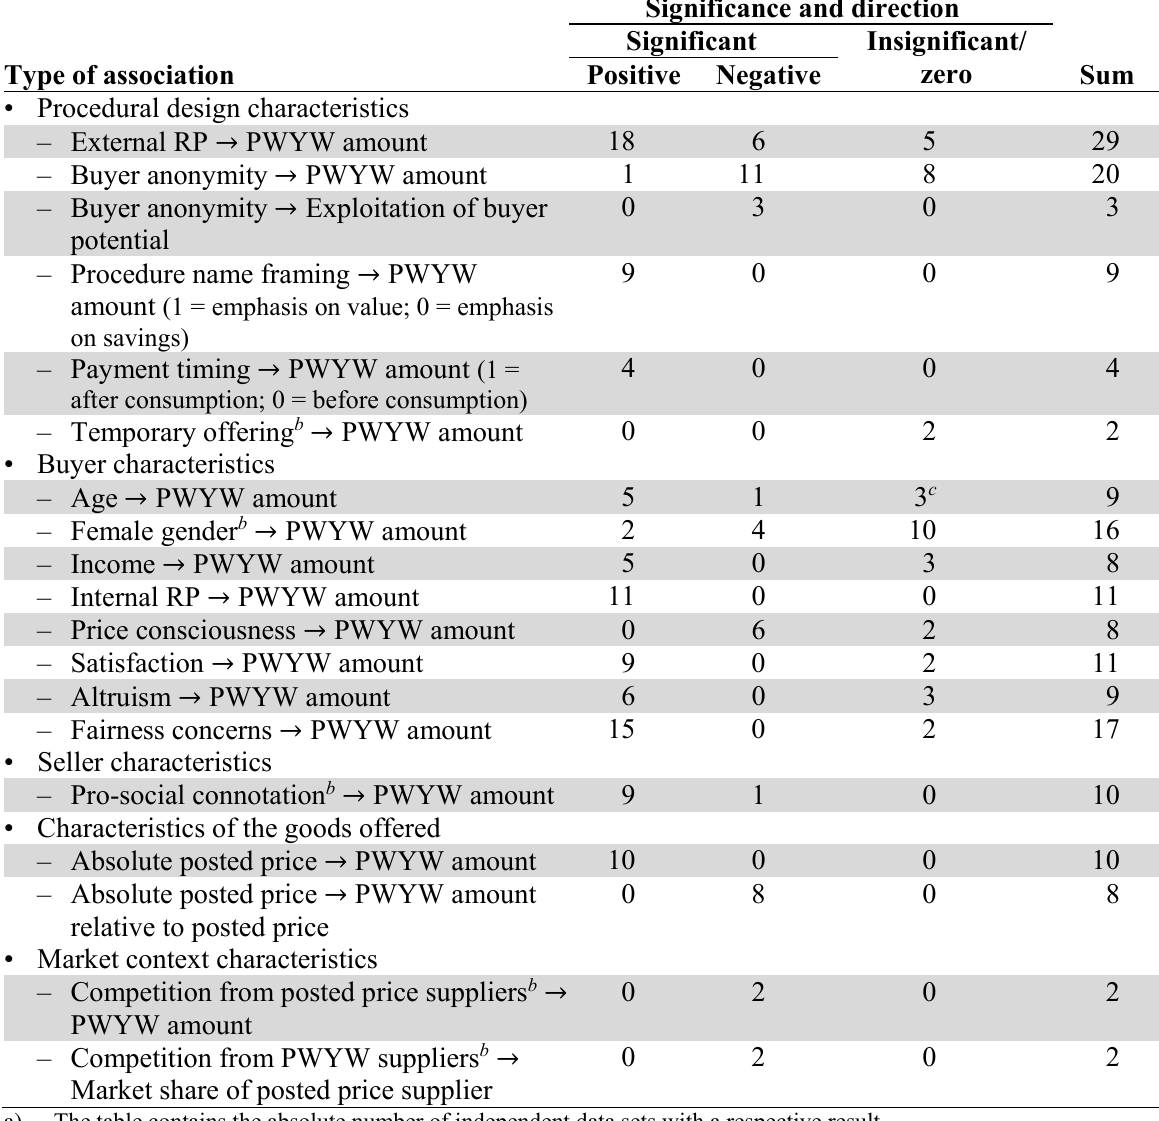
Significance and direction of variable associations in PWYW studies